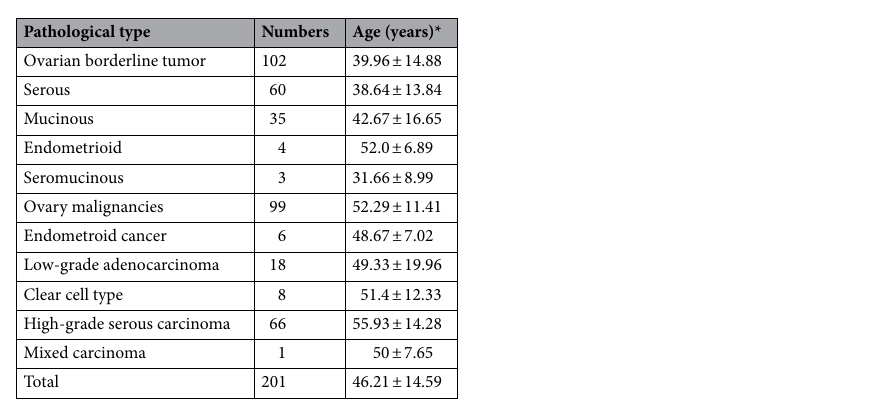
Table 1. The summary of the pathological types and numbers of the selected